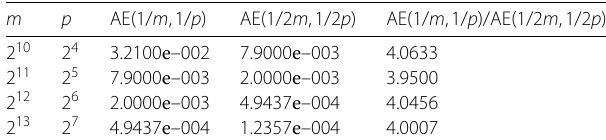
Figure 1 The numerical solution of (31) with θ = 0, m = 6400, p = 20 and r = 1/16